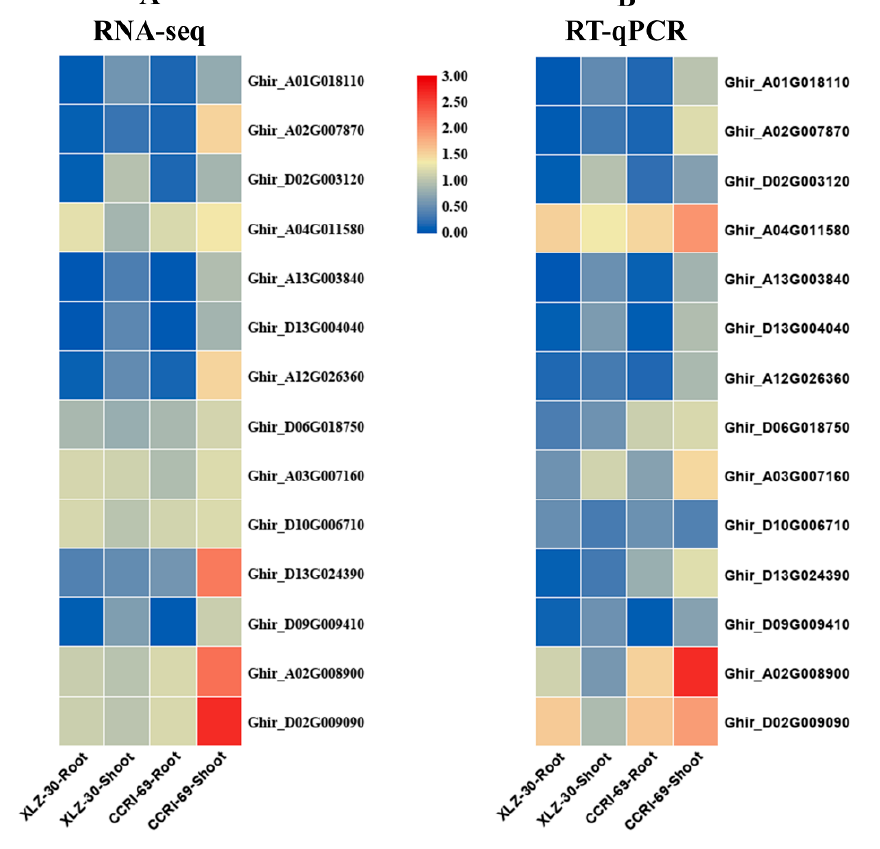
Figure 8. Validation of 14 differentially expressed genes (DEGs) related to nitrogen metabolism identified from transcriptome analysis by q-PCR. ( A ) RNA-seq based expression profiling; ( B ) q-PCR based expression profiling. The results were given as mean of three technical and biological replicates and expressed as fold change in mRNA relative expression.